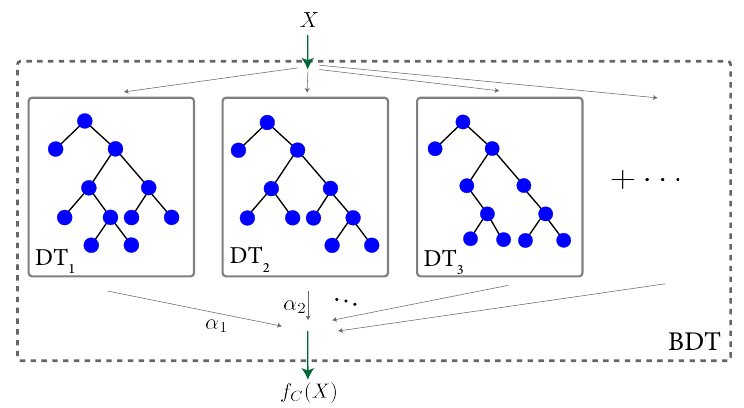
Figure 2: The architecture of a BDT. We take the BDT to be made of 150 DTs, with a max depth of 4. The input to the BDT are the variables that span the 5-body jet phase space, see Eq. (4). The indicated parameters α the particular